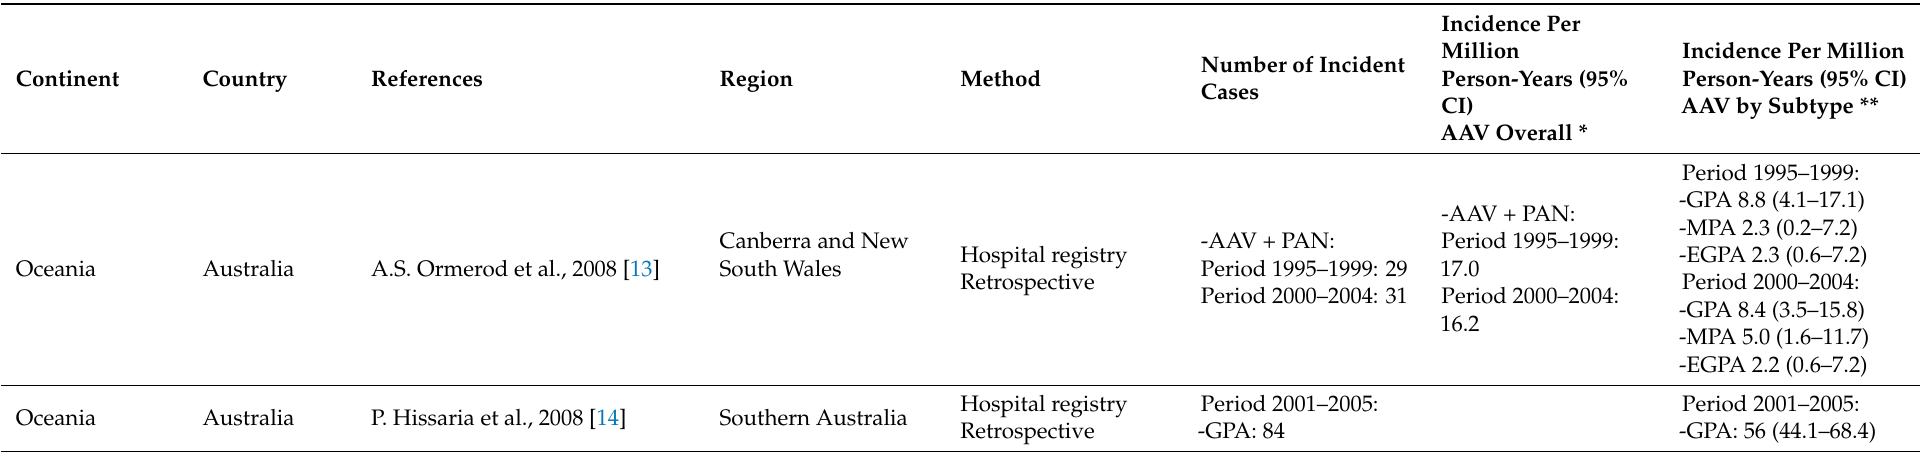
Table 1. Worldwide incidence of